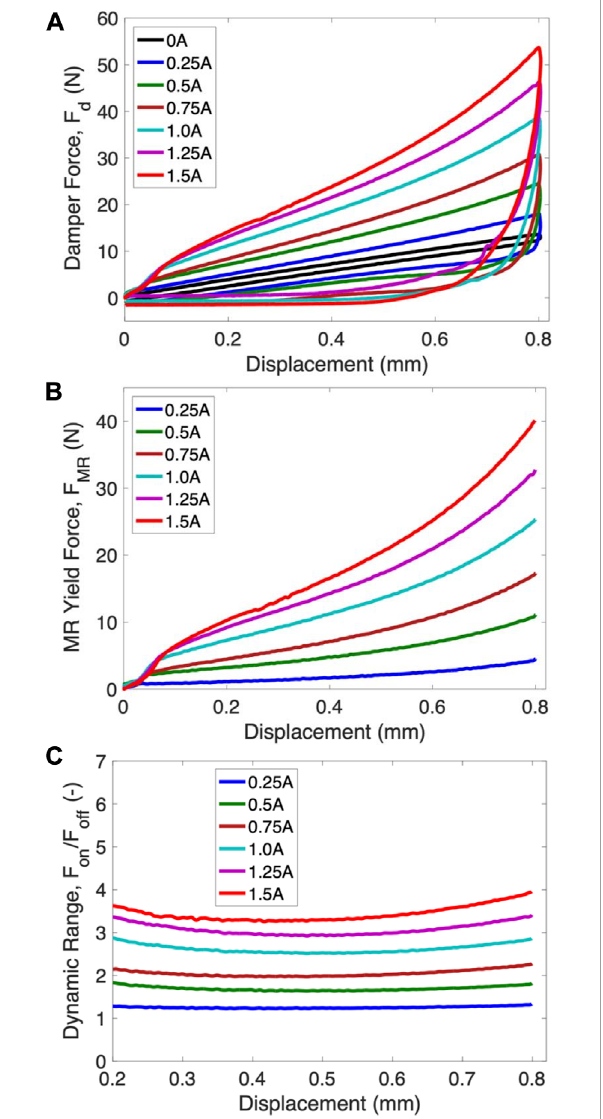
FIGURE 5 Magnetic field-controllable performances of the 3D-printed MRVI at the initial testing day. (A) F d . (B) F MR in compression direction. (C) DR in compression